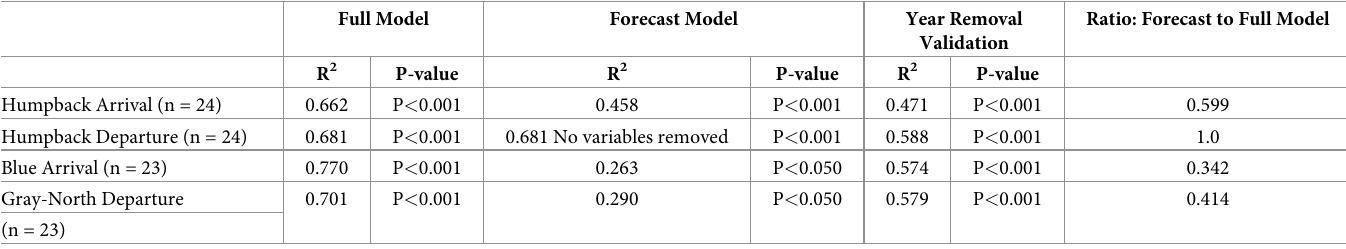
Table 4. Coefficient of determination and model significance comparison between the full, forecast, and year-removal validation